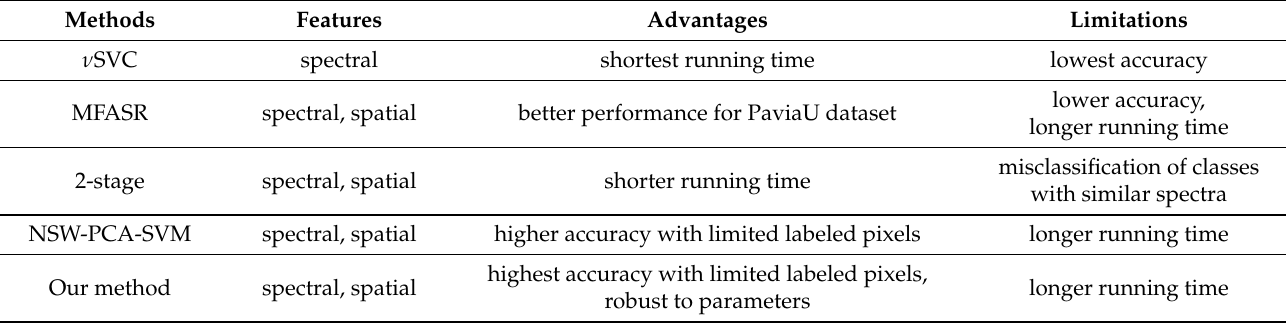
Table 8. The advantages and limitations of five methods with a small set of training pixels